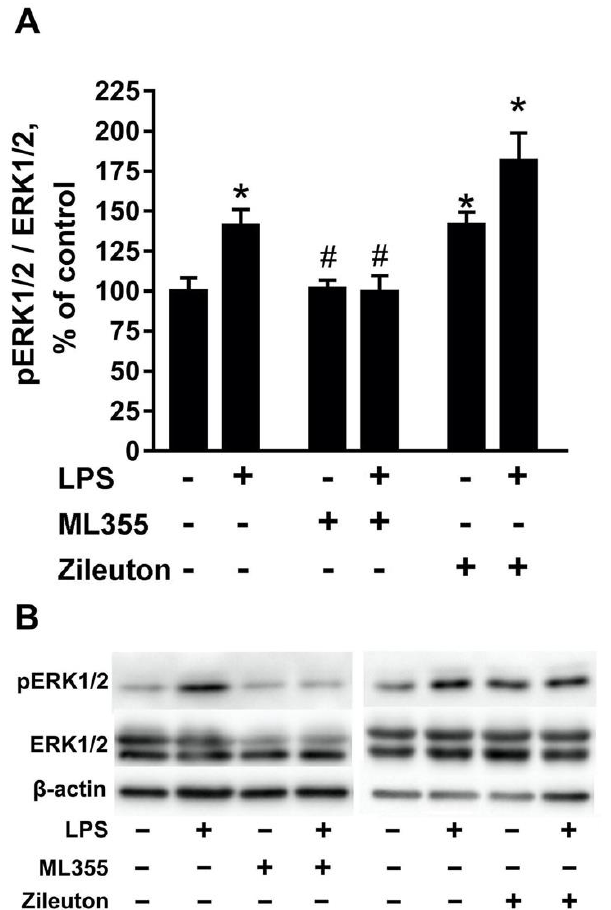
Figure 2. Effects of lipid fractions from the culture medium of treated astrocytes on ERK1/2 activity in neuronal cultures. The lipid fractions from astrocytes treated with LPS, ML355, LPS + ML355, Zileuton, and LPS + Zileuton were added to the primary rat cortex neuron cultures for 4 h. pERK1/2 and ERK1/2 protein levels were evaluated by Western blotting and normalized to the loading con- trol β -actin. ( A ) Results, expressed as fold-changes, relative to the control. ( B ) Representative West- ern blots demonstrating phospho-ERK1/2, total ERK1/2, and β -actin protein levels. The example is representative of four independent experiments. The values represent mean ± SD from four inde- pendent experiments. * — p < 0.05, compared with the neurons treated with lipid fraction obtained from native astrocytes; # — p < 0.05, compared with the neurons treated with lipid fraction obtained from LPS-stimulated astrocytes.